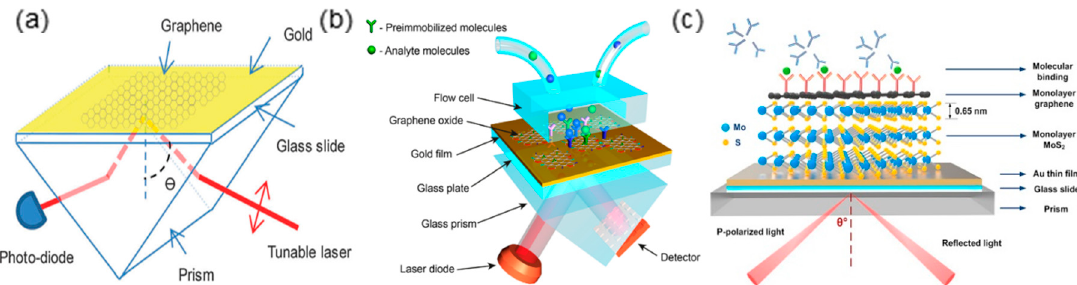
Figure 4. The prism based SPR configurations with hybrid plasmonic structures of ( a ) single-layer graphene / gold (Figure adapted with permission from reference [39]); ( b ) multilayer graphene / Py / gold (Figure adapted with permission from reference [42]); ( c ) graphene-MoS2 / gold (Figure adapted with permission from reference [46]).